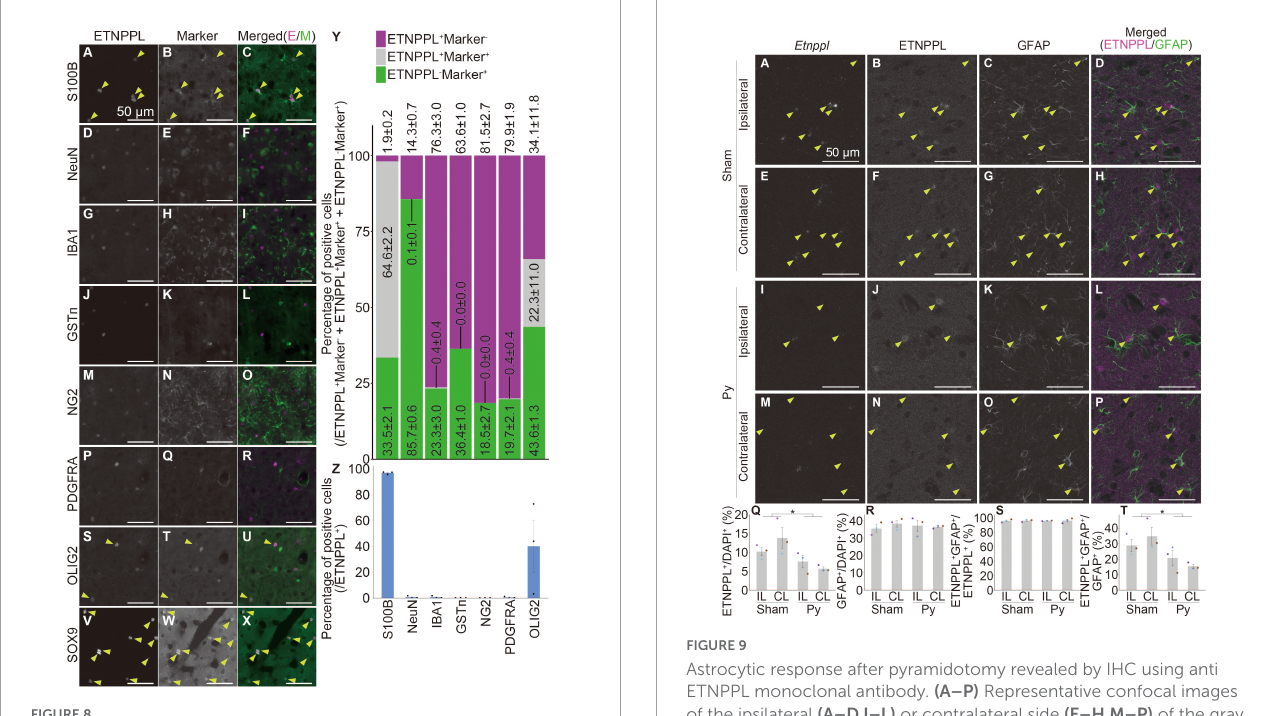
FIGURE8 Cellular specificity of ETNPPL-expressing cells in the cerebral cortex of adult mice. (A–X) Representative images of multiple staining of ETNPPL and cell markers in the cerebral cortex of 8 W female mice. Signals for ETNPPL (A,D,G,J,M,P,S,V) , S100B (B) , NeuN (E) , IBA1 (H) , GST π (K) , NG2 (N) , PDGFRA (Q) , OLIG2 (T) , or SOX9 (W) and their merged images (C,F,I,L,O,R,U,X) are shown. In the merged images, magenta indicates the signal for ETNPPL, and green indicates the signal for cell markers. Yellow arrowheads indicate cells double positive for ETNPPL and cell markers. Some experiments were not performed on the same day, and the brightness of the ETNPPL channels was adjusted differently. Scale bars: 50 µ m. The same ETNPPL channel images were used in (D,G,F,I,P,R,S,U) . (Y,Z) Quantification of the percentage of (Y) cells expressing ETNPPL and the cell markers or (Z) ETNPPL + cells labeled with a certain cell-type specific marker. Magenta indicates ETNPPL single positive cells, green indicates cell marker single positive cells, and gray indicates cells that are double positive for ETNPPL and cell markers. Mean ± S.E.M. n = 3 individuals, each of which is the average of three different sections.